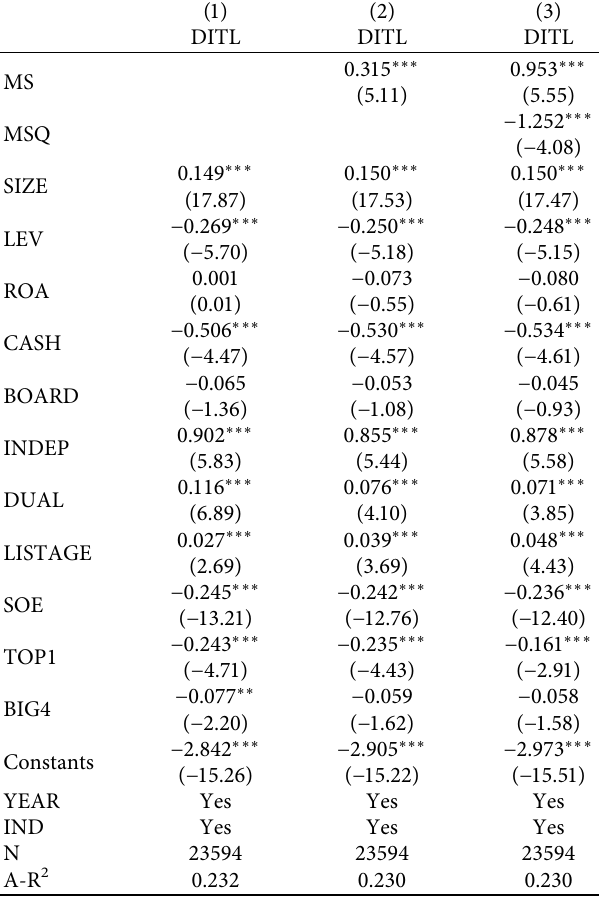
Table 2: Benchmark regression results of executive ownership and digital transformation.